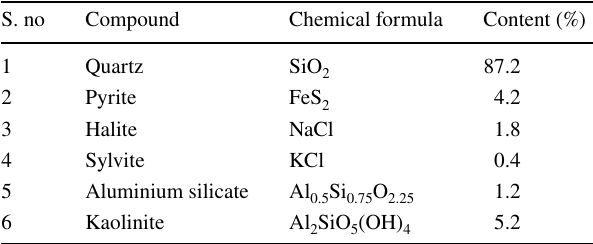
Table 1 Composition of the core samples from EDX